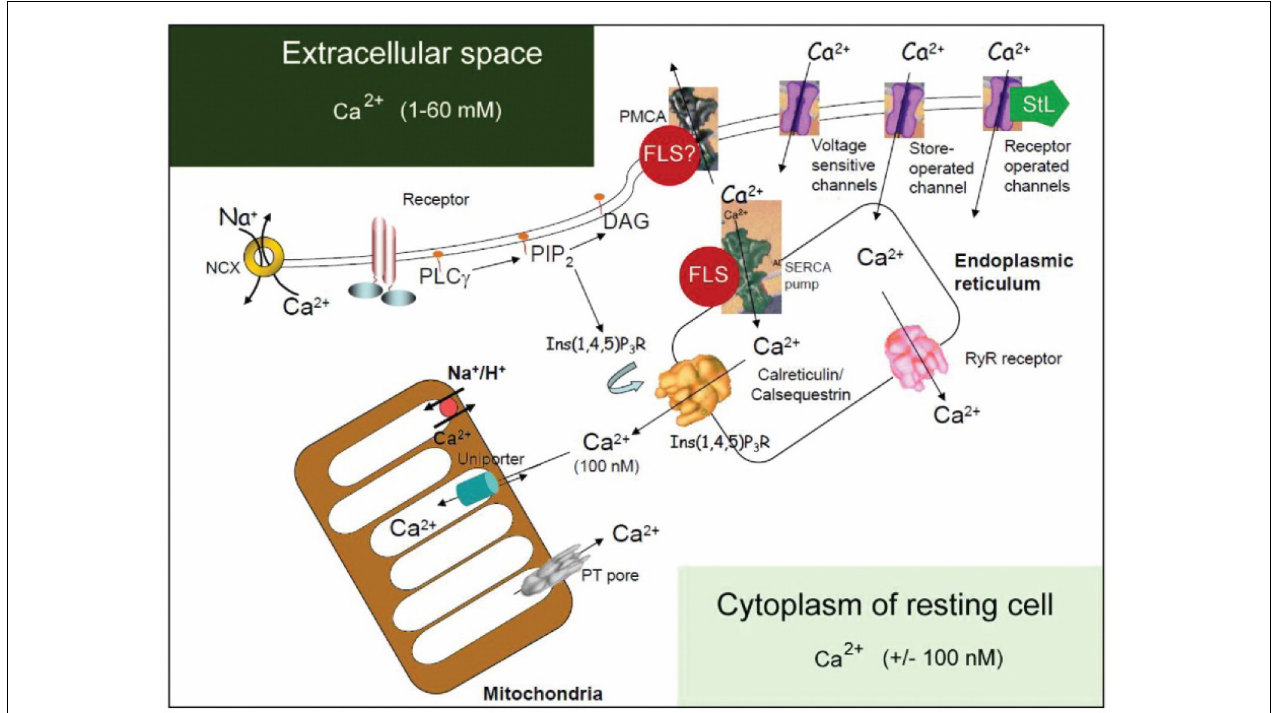
FIGURE 2 | Classical view of the major players in the system that regulates intracellular Ca 2 + compartmentalization. Cellular Ca 2 + import through the plasma membrane occurs largely by receptor-operated (e.g., glutamate receptors), voltage-sensitive and store-operated channels. Once inside the cell, Ca 2 + can either interact with Ca 2 + -binding proteins or become sequestered into the endoplasmic reticulum (ER) or mitochondria. The largest Ca 2 + store in cells is found in the ER or sarcoplasmic reticulum, with local Ca 2 + concentrations reaching millimolar levels. Ca 2 + levels in the ER are affected by the relative distribution of sarco(endo)plasmatic reticulum Ca 2 + -ATPase (SERCA) pumps and of inositol-1, 4, 5-triphosphate [Ins(1, 4, 5)P 3 ] receptors [Ins(1, 4, 5)P 3 Rs] and ryanodine receptors (RYRs), as well as by the relative abundance of Ca 2 + -binding proteins (calreticulin, calsequestrin) in the ER or sarcoplasmic reticulum. The cytosolic Ca 2 + concentration in unstimulated cells is kept at approximately 100 nM by both uptake into the ER and Ca 2 + extrusion into the extracellular space by the plasma membrane Ca 2 + -ATPase (PMCA). ER Ca 2 + release is triggered by agonist stimulation through the generation of Ins(1, 4, 5)P 3 through hydrolysis of phosphatidylinositol-4,5-biphosphate [PtdIns(4,5)P 2 ] operated by a phospholipase C (PLC γ ). The mitochondria take up Ca 2 + electrophoretically through a uniport transporter and can release it again through three different pathways: reversal of the uniporter, Na + /H + -dependent Ca 2 + exchange, or as a consequence